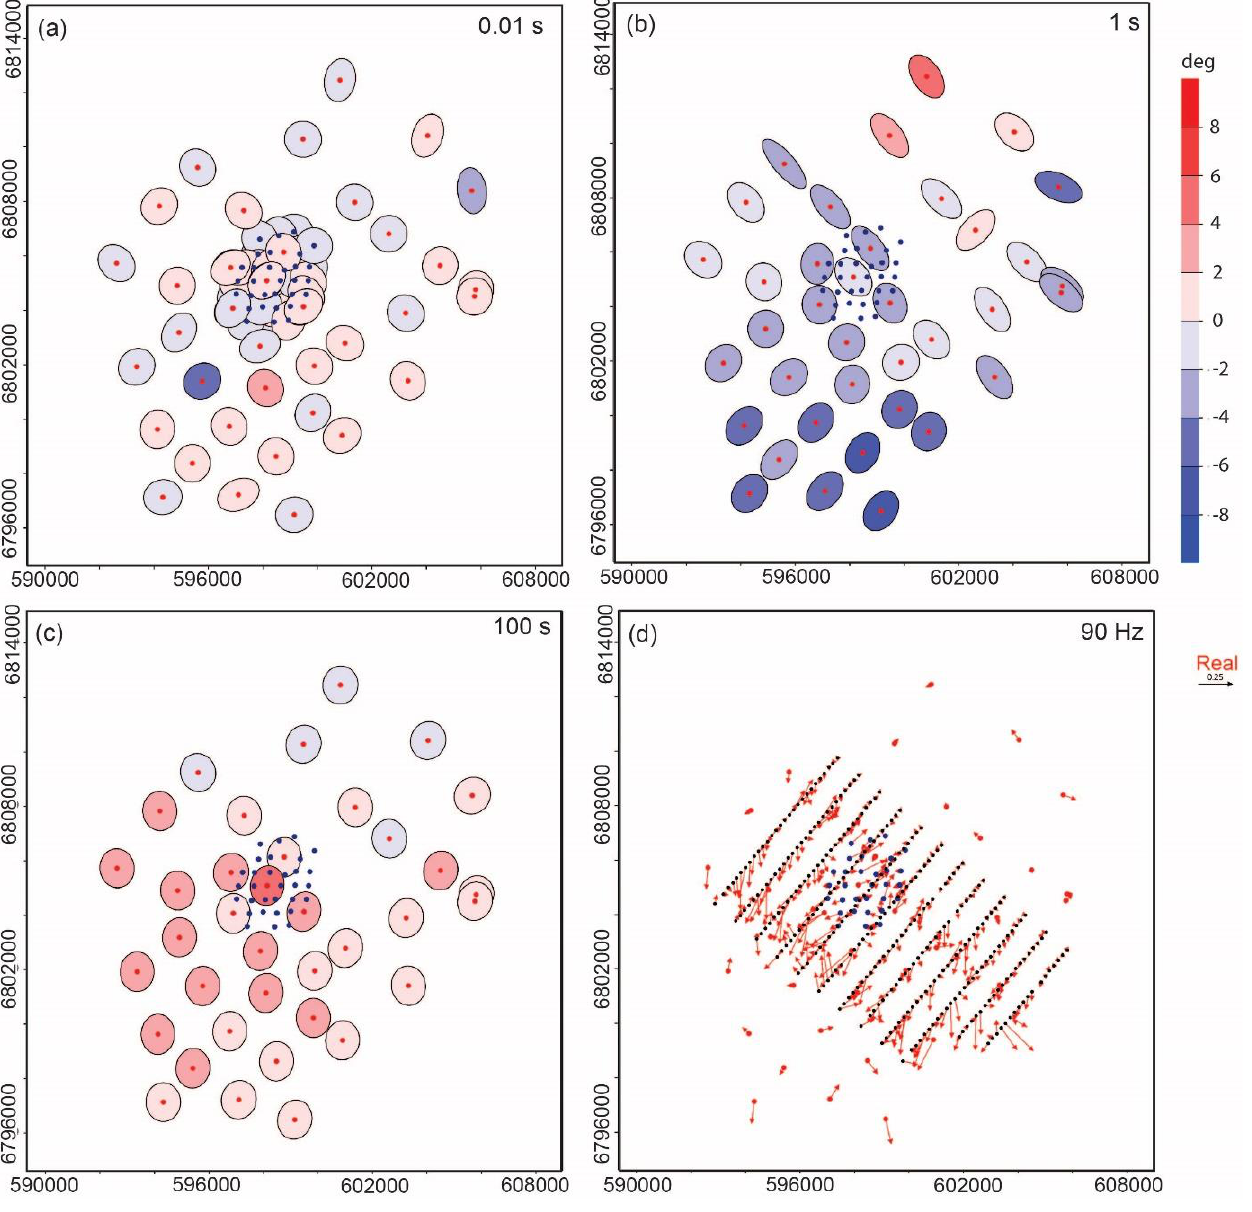
Figure 4. Phase tensor ellipses at AMT (blue dots) and MT sites (red dots) for periods of ( a ) 0.01 s; ( b ) 1 s; and ( c ) 100 s. Ellipse color denotes the value of β. ( d ) Induction arrows at 90 Hz for ELF-EM (black dots), AMT and MT stations. UTM coordinates are in North American Datum 1983 UTM zone 7N.